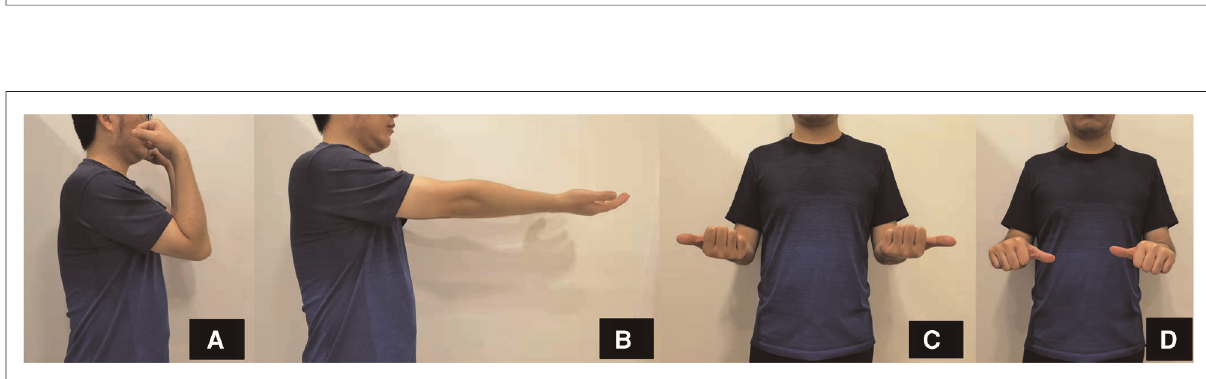
FIGURE 3 ( A,B ) Postoperative x-ray fi lms of the left forearm. ( C,D ) X-ray fi lms of the patient at 1 month after surgery. ( E,F ) X-ray fi lms of the patient after removal of the internal fi xation at 12 months after